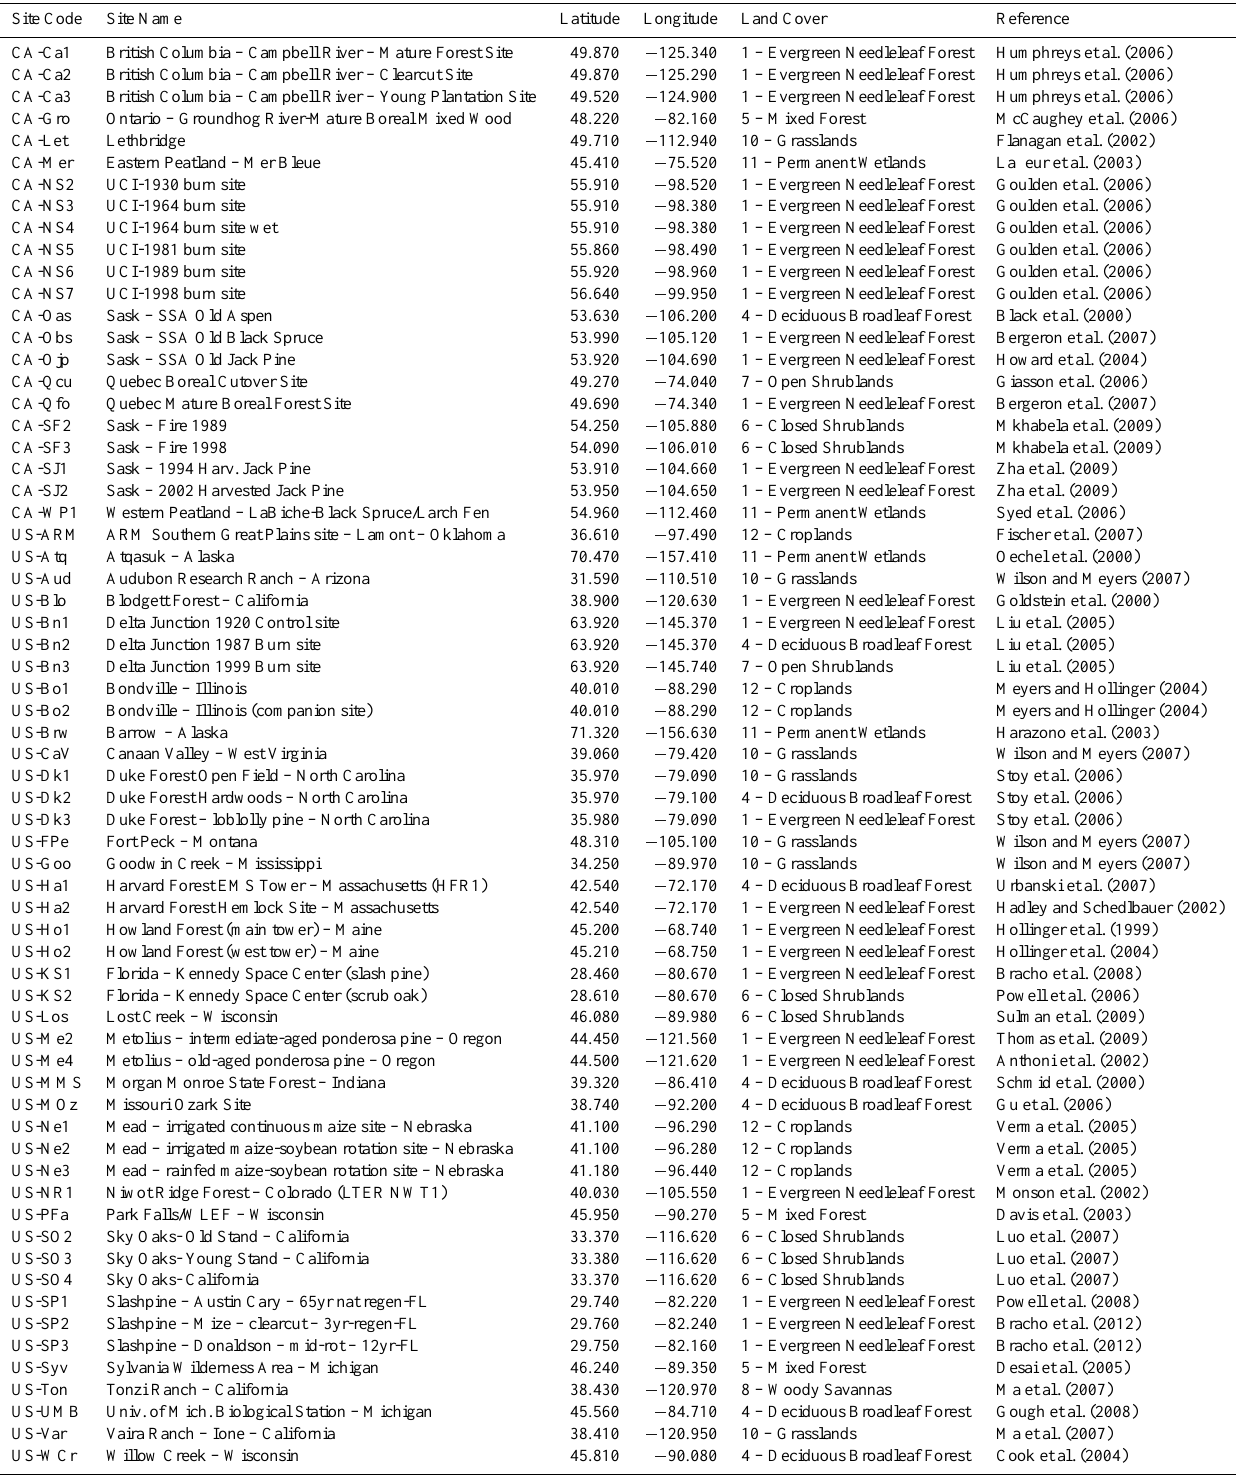
Table 1. 65 North American eddy covariance sites used to parameterize VPRM and calculate VPRM flux errors. PFTs are taken from the International Geosphere-Biosphere Programme (IGBP) land cover classification scheme (Loveland and Belward, 1997). The PFT classifica- tions are taken from literature citations or investigator descriptions where available, and otherwise derived from MODIS 1km land surface classifications. Data are from the 2007 Fluxnet Synthesis